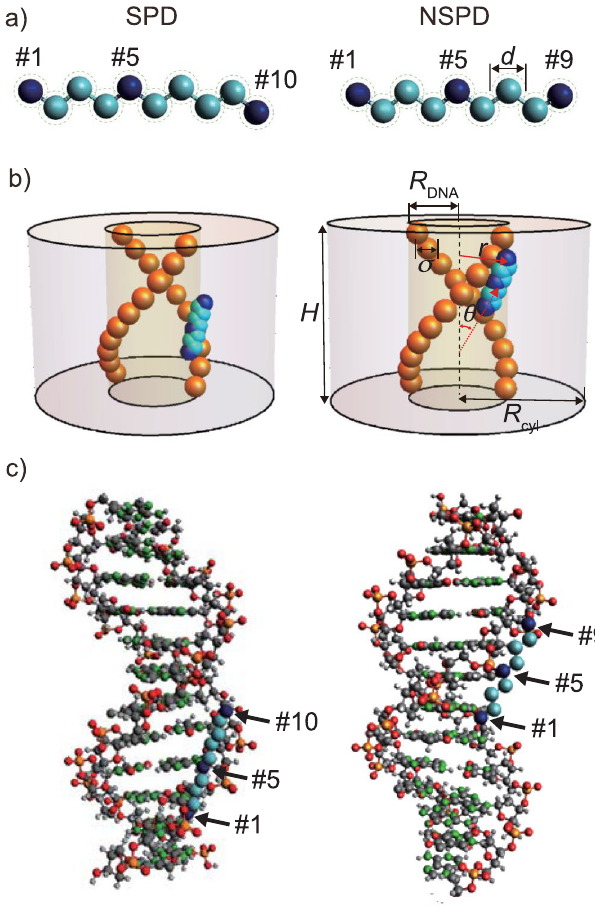
Figure 6. Simulation model for rigid SPD and NSPD in ( a ) and typical snapshots in the simulation for SPD and NSPD interacting with double-stranded DNA in ( b ) and ( c ), when the strength of electrostatic interaction Γ = 1.36 nm. For the numerical simulation in ( b ), pairs of charged spheres to mimic phosphate groups are placed in a soft cylinder of length H ( = 3.4 nm) and radius R DNA ( = 1.0 nm) under a periodic boundary condition. The pictures in ( c ) represent the atomistic detail of the coarse-grained model. Hydrogen atoms are omitted for clarity. The positions of the three ammoniums in SPD and NSPD are indicated by #. In our model, a polyamine is allowed to partially penetrate into the DNA interior, which mimics minor and major grooves. The adjacent pairs of negatively charged moieties in the DNA model are separated by 0.34